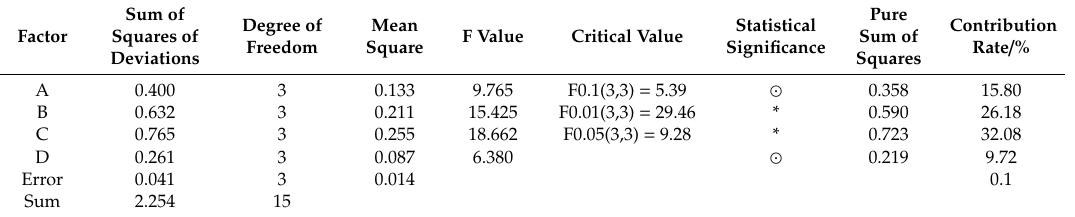
Table 9. Variance Analysis and Contribution Rate of Factors and Errors to Flexural